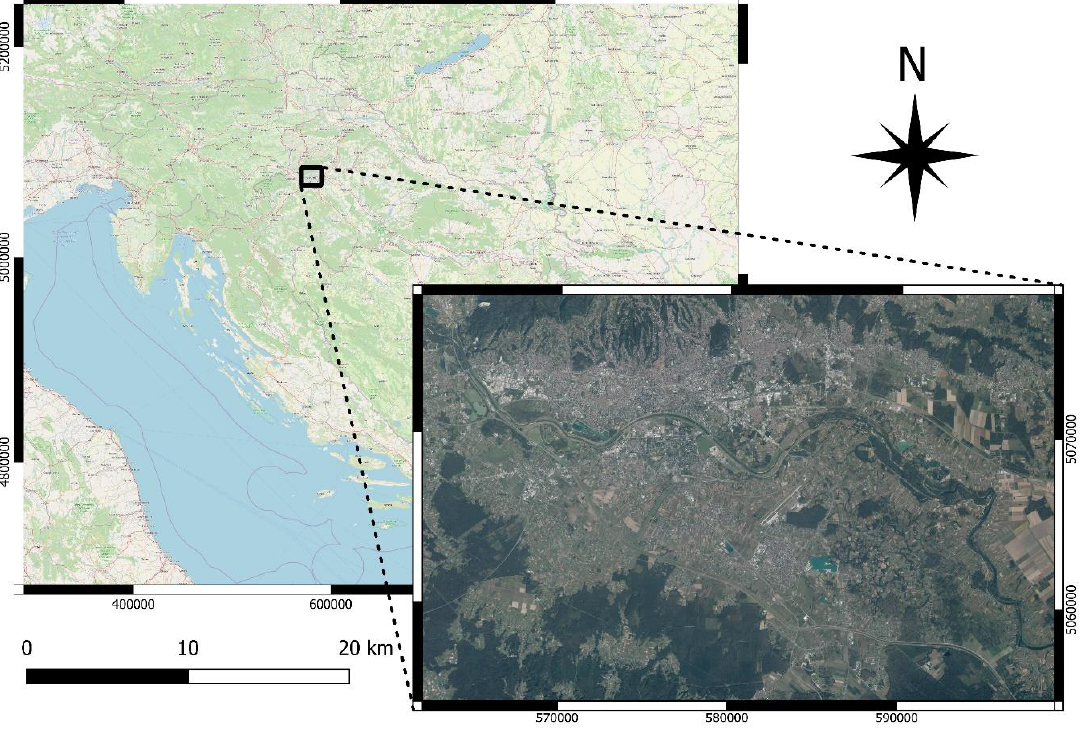
Table 1. Satellite images used in this study.